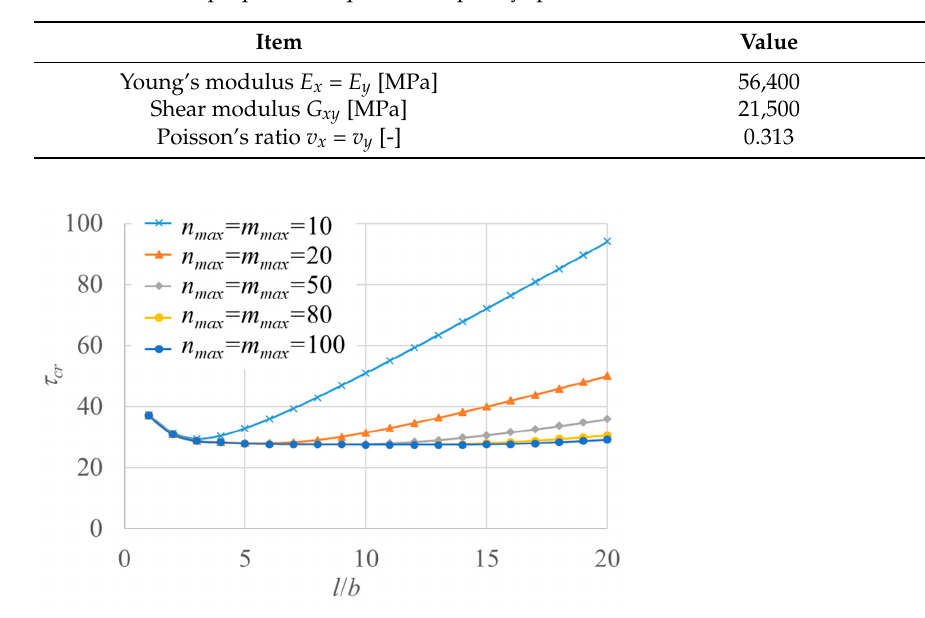
Table 1. Material properties of quasi-isotropic layup of T300 CFRP.